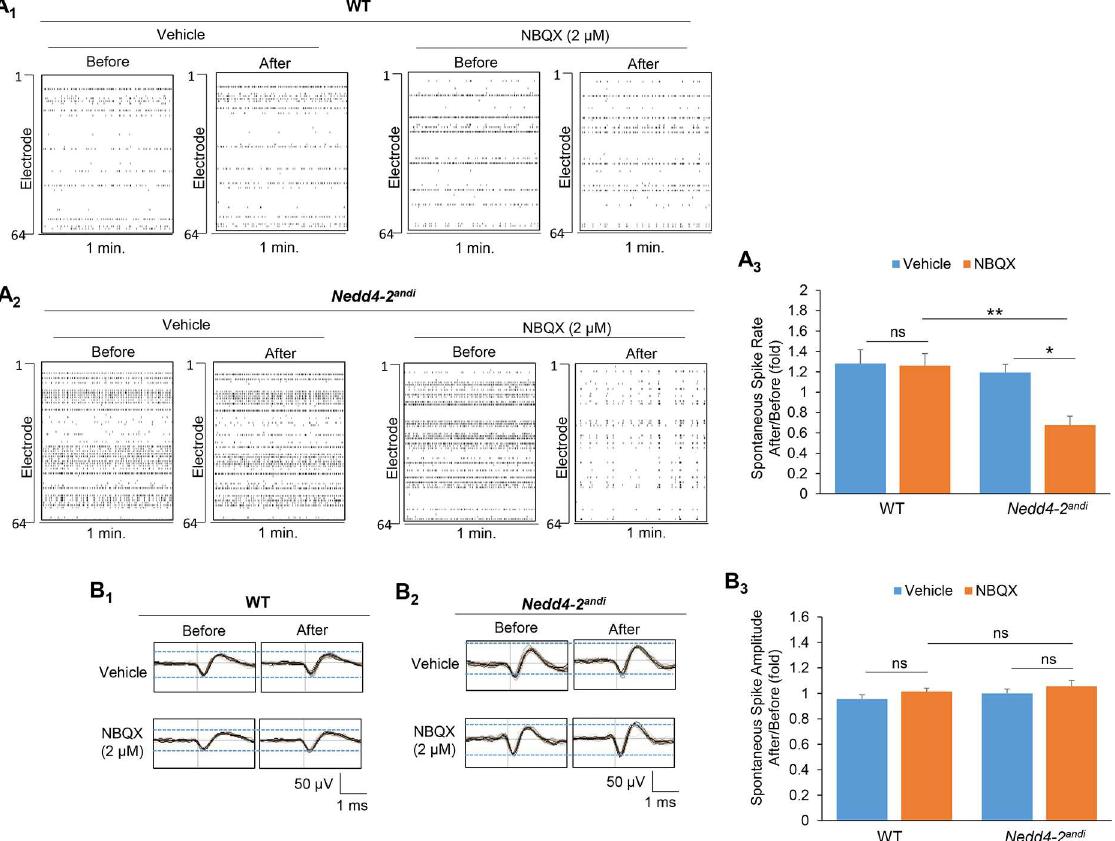
Fig 3. Nedd4-2 andi cortical neuron cultures are more sensitive to acute AMPAR blockade than WT cultures in reduction of spontaneous neuronal activity. ( A ) Representative raster plots and quantification of spontaneous spikes from 1-min recording (right) of ( A 1 ) WT or ( A 2 ) Nedd4-2 andi cortical neuroncultures before and after vehicle(DMSO) or NBQX (2 μ M) treatment for 15 min. (Vehicle: n = 9 and 5 for WT and Nedd4-2 andi ; NBQX: n = 8 and 5 for WT and Nedd4-2 andi ) ( B ) Representative averagetraces of 1-min recordingand quantification of averagespontaneous spike amplitudeof ( B 1 ) WT or ( B 2 ) Nedd4-2 andi cortical neuron cultures before and after vehicle(DMSO) or NBQX (2 μ M) treatment for 15 min (Vehicle: n = 9 and 5 for WT and Nedd4-2 andi ; NBQX: n = 8 and 5 for WT and Nedd4-2 andi ). The black lines represent the averageof all the spikes within representative 1-min recordings. Data are analyzedby a 2-way ANOVA with post-hoc Tukey test and representedas mean ± SEM. The comparison betweentreatments or genotypes is describedwith ** p < 0.01,ns: non-significant. Significantinteraction betweentreatment and genotypewas detected in spontaneous spike rate (A 3 ; p < 0.05)but not amplitude(B 3 ; p >